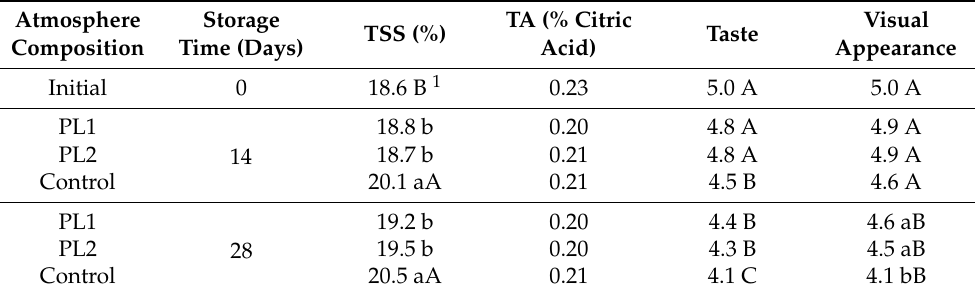
Table 1. Total soluble solids (TSS), titratable acidity (TA), taste and visual appearance of Bursa Siyahi fig cultivar under palliflex storage system during cold storage.